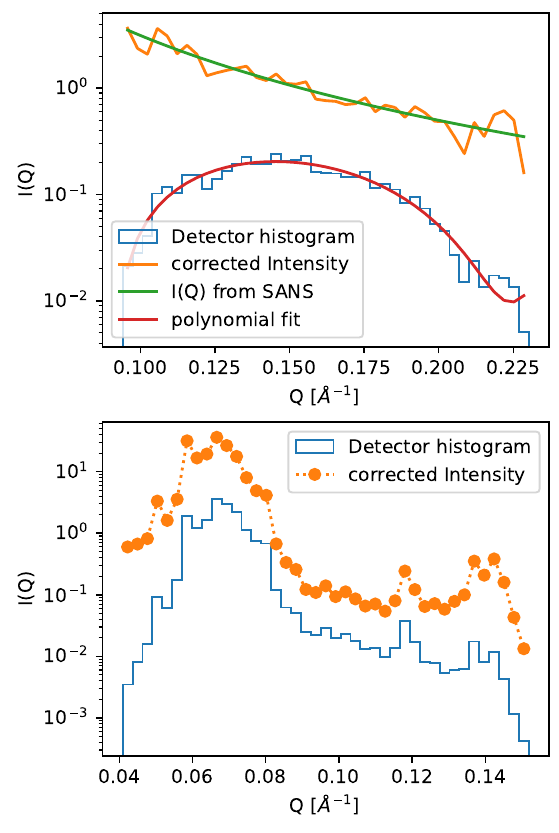
Figure 4. Histogram of q-intensities of the NSE experiment for the bicontinuous (top) and lamellar microemulsion (bottom). From previous SANS experiments on bicontinuous microemul- sions the relevant Q-range has been fitted on an absolute scale and used to determine the detector